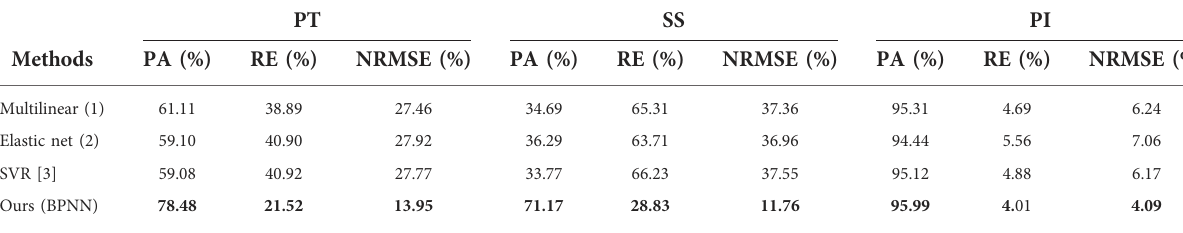
TABLE 4 The performance of different methods for predicting sitting PT, SS, and PI. The larger PA and smaller RE and NRMSE , the better the performance. Bold means the best. PT SS PI